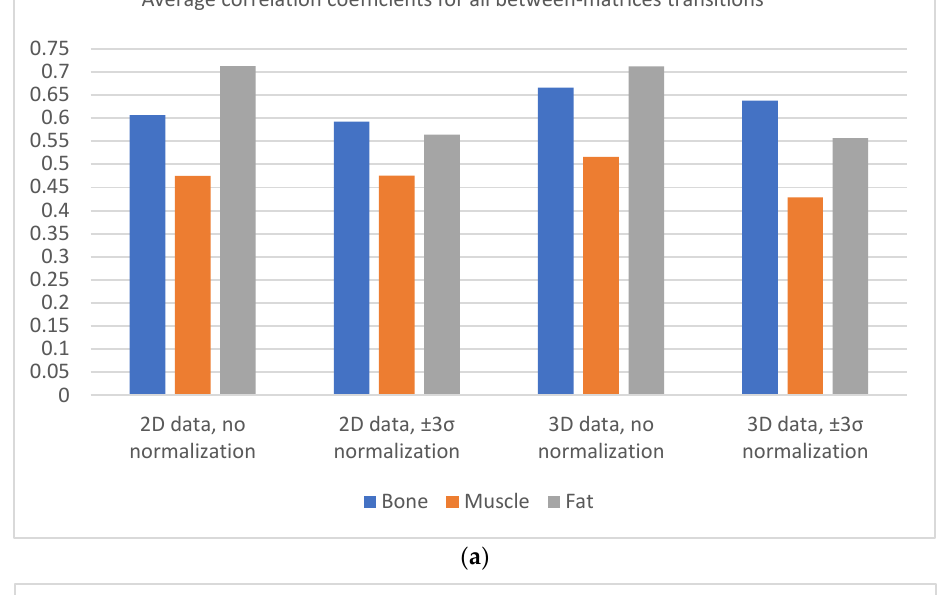
Figure 8. Acquisition times for all patients.